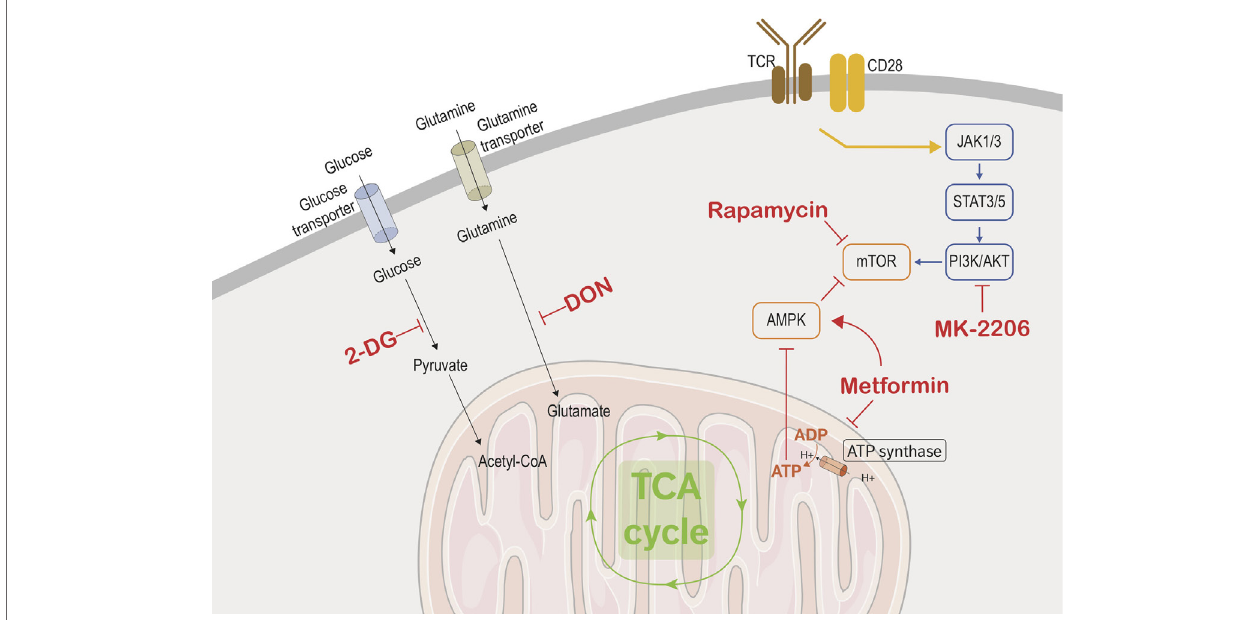
FiGURe 2 | immunometabolic targets . This figure depicts the different metabolic and transcriptional pathways involved in the immunometabolic functions of CD8 T cells. Black arrows are used to show the transport of glucose and glutamine into the cells where they are metabolized. The yellow arrow represents the combined signaling of the TCR and CD28 which activates CD8 effector cells and triggers the metabolic adaptations in the effector cells. The blue arrows show the transcriptional used by activated CD8 T cells to upregulate mTOR, which controls cellular metabolism and growth. Red arrows show the promotion or suppression of therapeutic molecules on the various immunometabolic